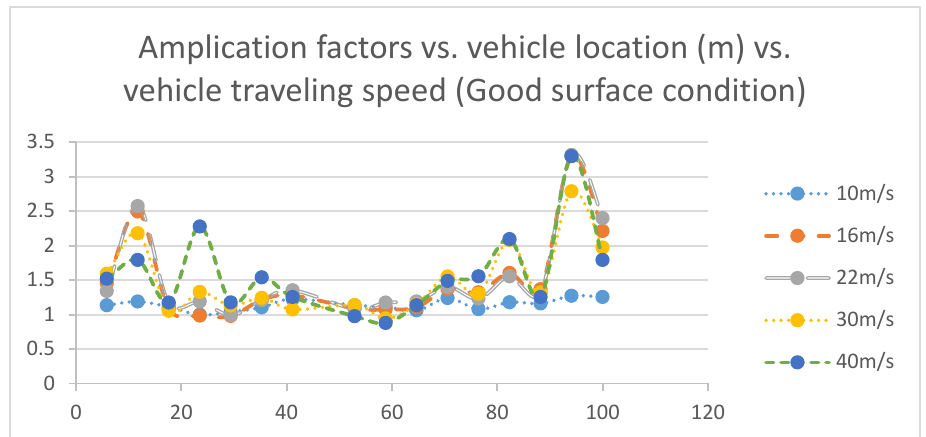
Fig. 4. Amplication factors of different traveling